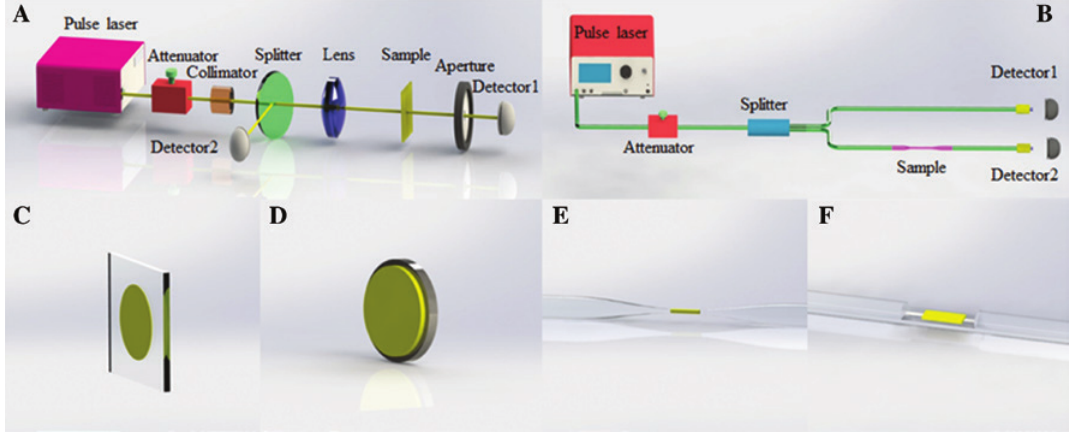
Figure 4: Z-scan and double-arm methods; Coupling methods of LD materials. Schematic of the Z-scan measurement setup (A) and of the two-arm measurement setup (B). Coupling methods between nanomaterials and devices including quartz (C), high-reflection mirror (D), microfiber (E), and D-shaped fiber